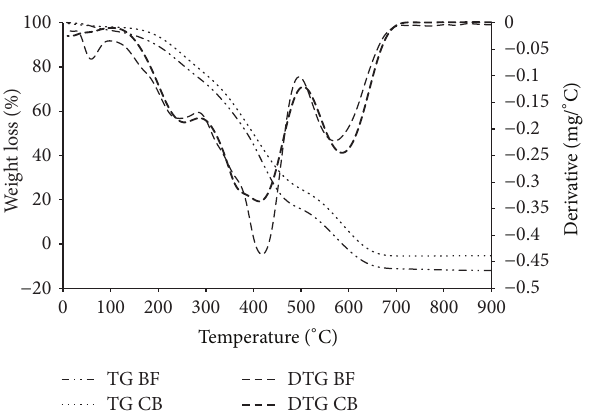
Figure 2: Thermogram weight loss of CB samples with UV irradia- tion.